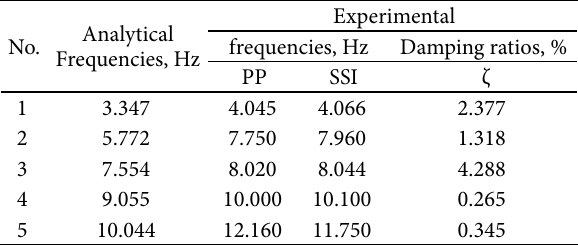
Table 3. Analytical and experimental frequencies after FEM updating No.